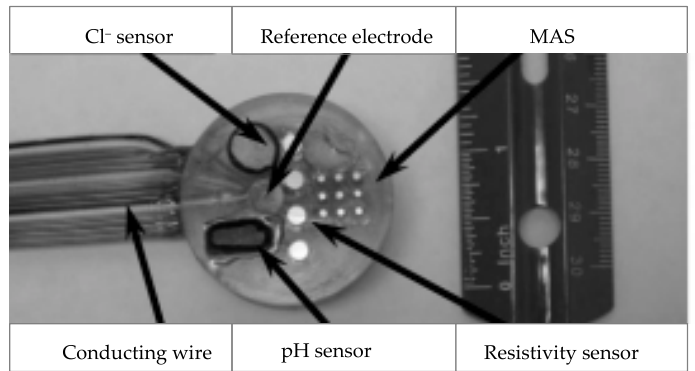
Figure 4. Image of the sensor package configuration, adopted from [55].